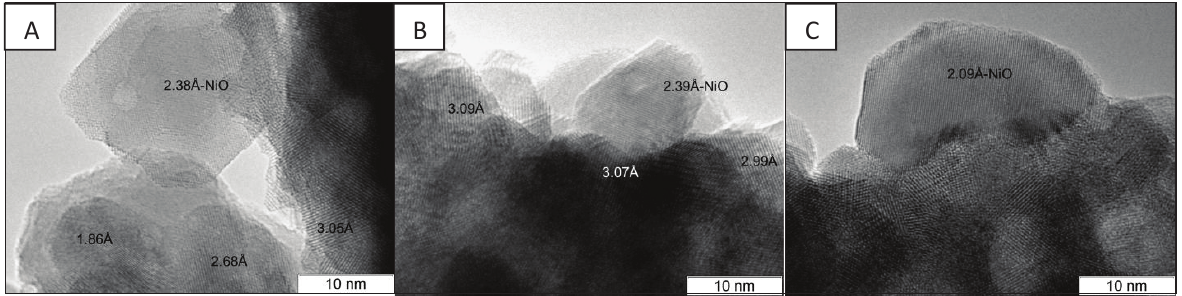
interfacial region and not a sharp metal-support interface, was observed previously [22].